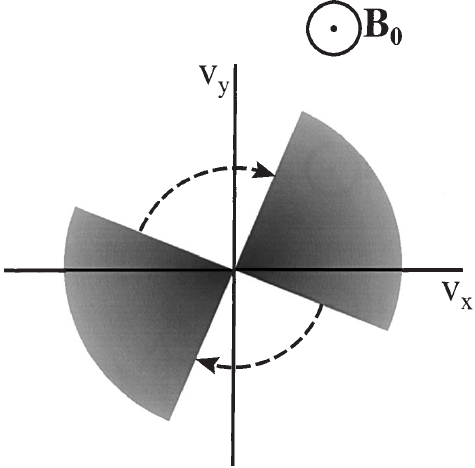
Fig. 2. Sketch of a rotating nongyrotropic distribution function. The whole distribution function of positively charged ions ( shaded region ) is rotating around the ambient magnetic field. The distribution is Q symmetric to prevent zero order